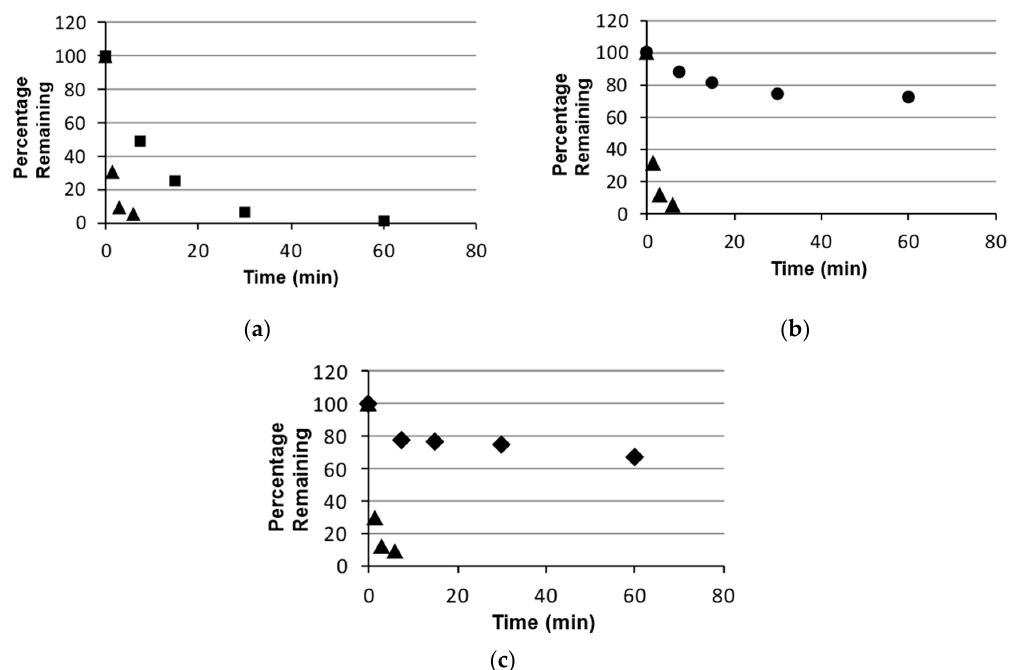
Figure 4. The pronase digestion profiles of compounds 5 ( ■ ), 6 ( ● ), 7 ( ◆ ), and the linear pentapeptide H 2 N-HK-(N ε -acetyl-lysine)-LM-COOH ( ▲ ). Note: The linear pentapeptide H 2 N-HK-(N ε -acetyl-lysine)-LM-COOH has been used extensively in our laboratory as a control of the pronase digestion